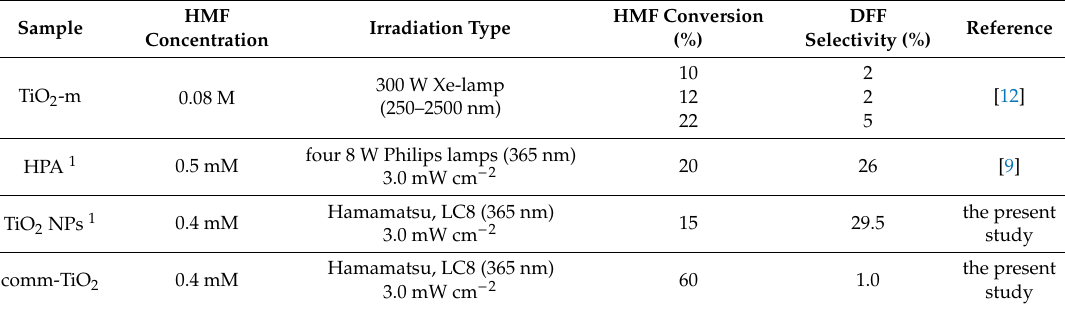
Table 1. Comparison of photocatalytic performance of the TiO 2 nanoparticles (NPs) with other TiO 2 photocatalysts for HMF oxidation.